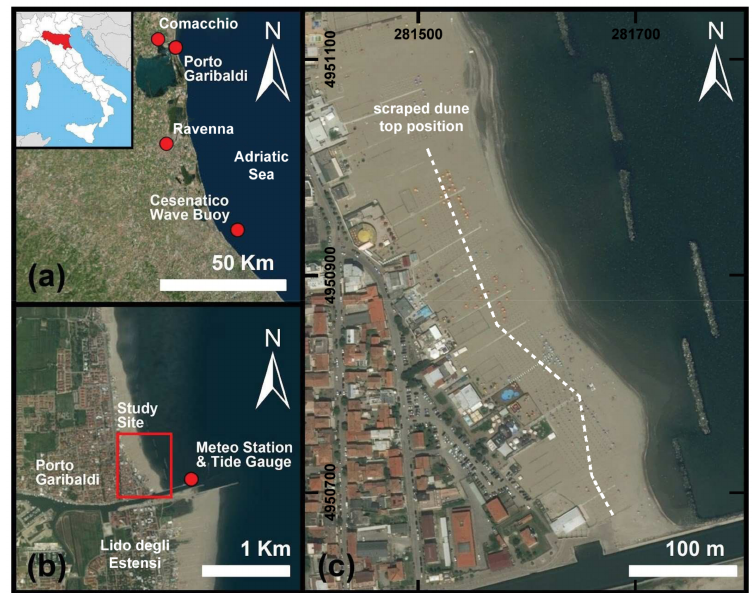
Figure 1. Index map of the study area: ( a ) the Emilia-Romagna (red region) coast in the Northern Adriatic; ( b ) the Porto Garibaldi (Comacchio) area; ( c ) the study site, just north of the canal harbour of Porto Garibaldi. The locations of measuring stations are highlighted in ( a , b